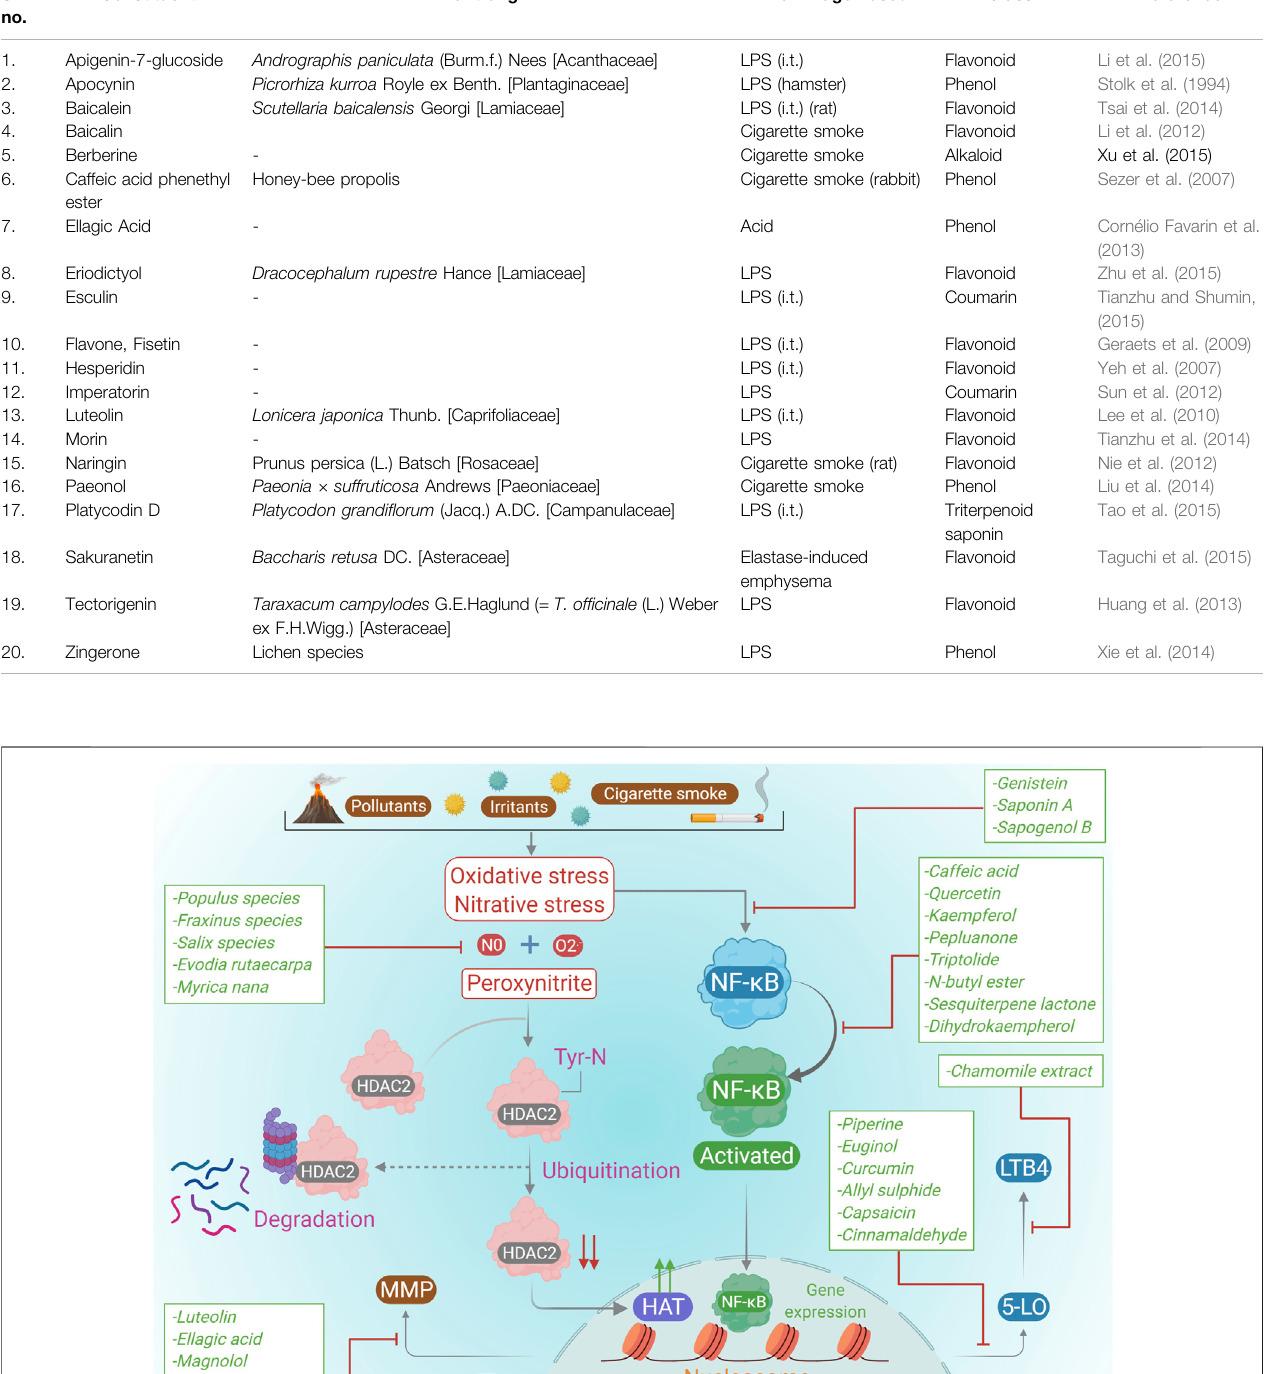
TABLE 2 | Different plant constituents inhibiting lung in fl ammation. Sl. no.